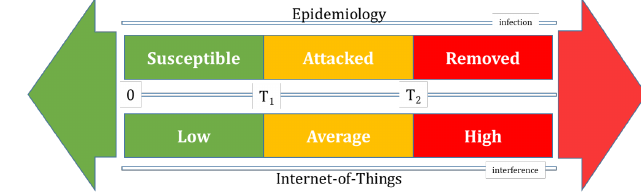
( a ) Interference thresholds defining epidemic sets.